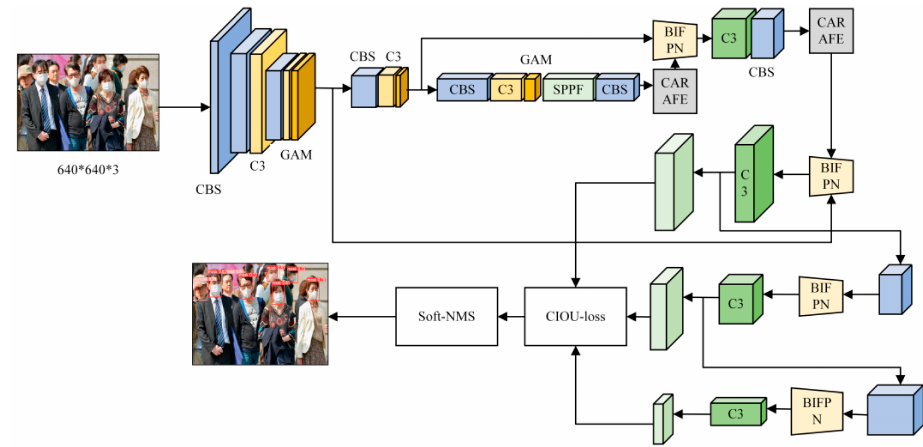
Figure 2. YOLOv5-GBC network structure.